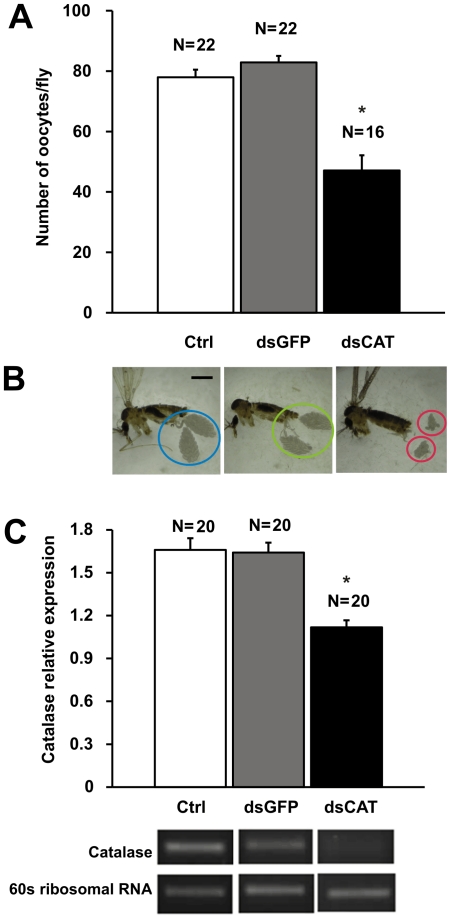
RNAi-mediated depletion of catalase LlonKat1 in female Lu. Longipalpis and its effect on fecundity.(A) Average number of developing oocytes dissected 48 hours days after blood meal ± SEM (combined samples derived from 2 independent experiments). Asterisk indicates statistical significance at P<0.005(ANOVA). (B) Relative development of female Lu. longipalpis ovaries observed upon catalase gene knockdown by RNAi, in comparison to mock-injected and uninjected control sand flies. Bar = 1 mm. (C) Relative expression of catalase LlongKat1 mRNA in whole fly homogenates from dsRNA-injected catalase knock-down sand flies. Bar charts represent mean ± SEM of combined samples from at least 2 independent experiments. Asterisk indicates statistical difference at P<0.05 (ANOVA).